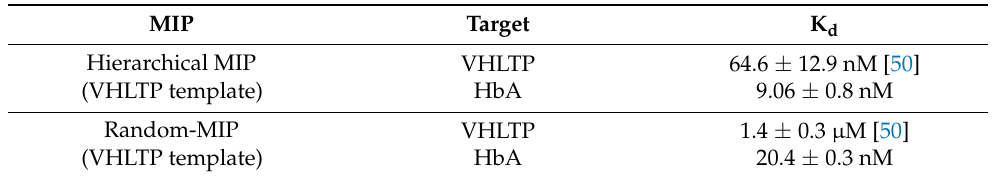
Figure 2. Comparison of the concentration-dependent relative suppression of the SWV signals (peak currents) detected for the binding of the template peptide VHLTP (green), HbA (concentration of ß-subunits of HbA, black), HSA (red), and BSA (blue) to the hierarchical MIP. Table 1. K d values determined for binding of the target peptide and HbA to the hierarchical and mixture-based MIPs.